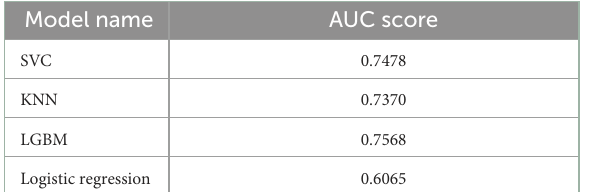
TABLE 3 AUC score of TOP-4